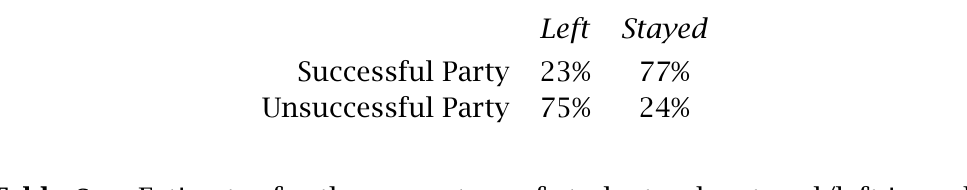
Estimates for the percentage of students who stayed/left in each